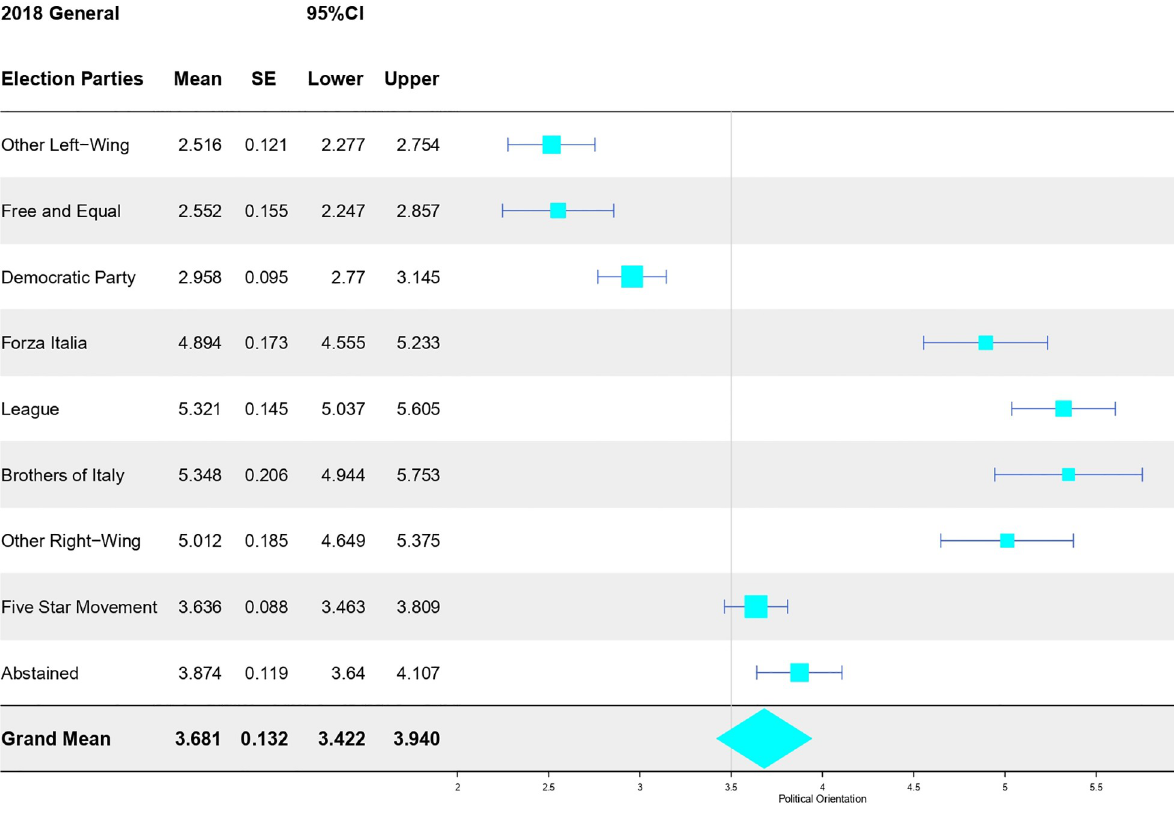
Fig 7. Forest plot of political orientation’s average scores across voters of candidate parties in the 2018 general election.